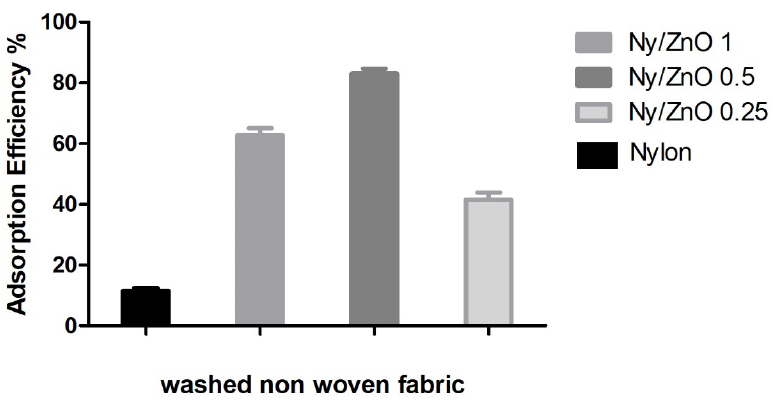
Figure 6. The adsorption efficiency of nylon, Ny/ZnO 1, Ny/ZnO 0.5, Ny/ZnO 0.25 washed non- woven fabric (MB concentration = 200 mg/L; nanocomposite content = 20 mg/20 mL; T = 25 °C and t = 60 min).